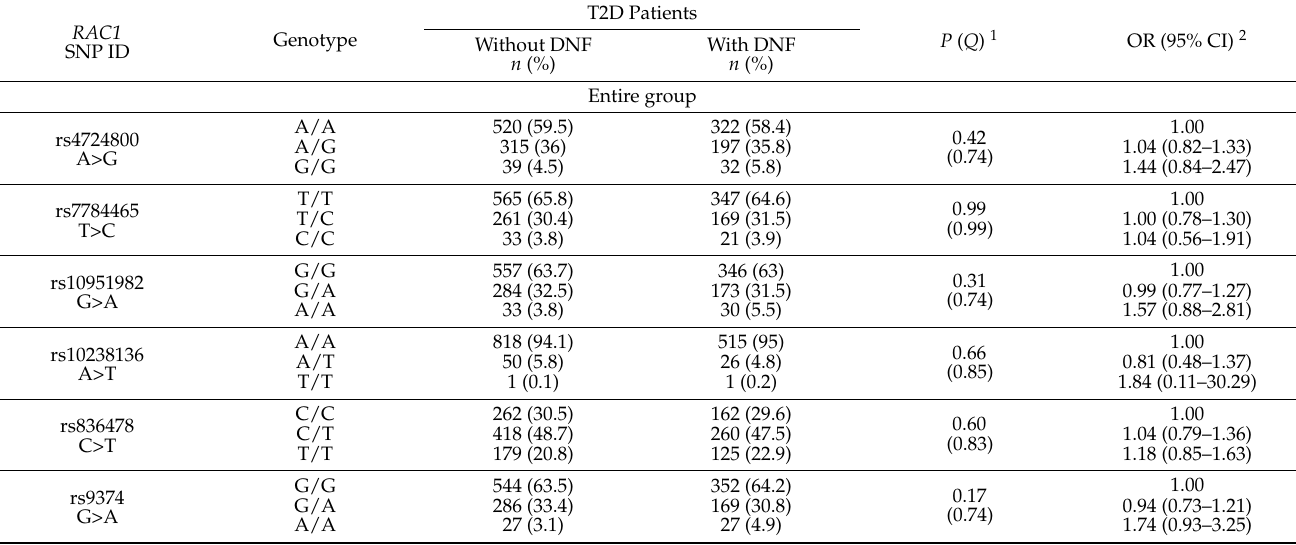
Table 4. Genotype frequencies for the studied gene polymorphisms among T2D patients with and without diabetic